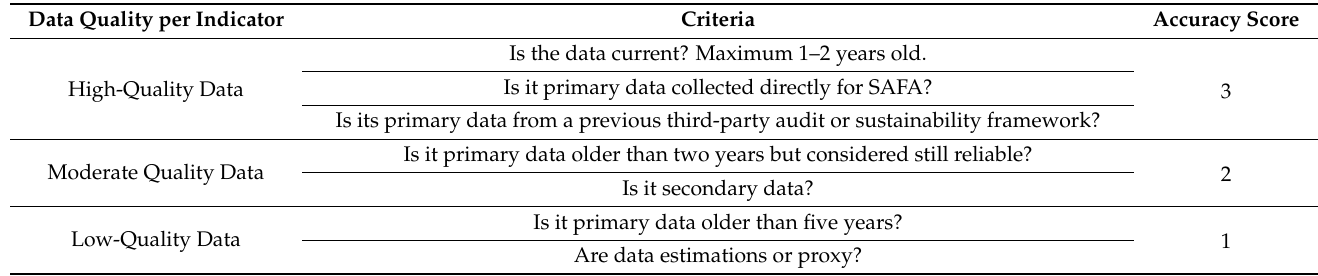
Table 4. Accuracy score depends on data reliability. Source information: SAFA Guidelines.